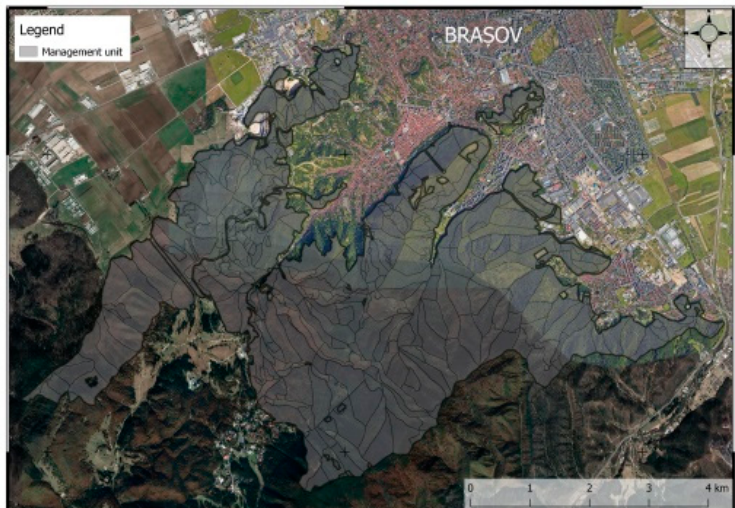
Figure 1. Location of the studied forest management unit.